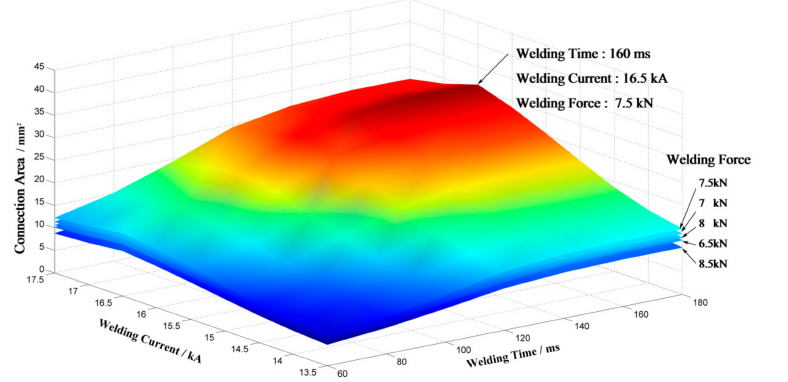
Figure 14. The comprehensive influence of the welding parameters on the connection